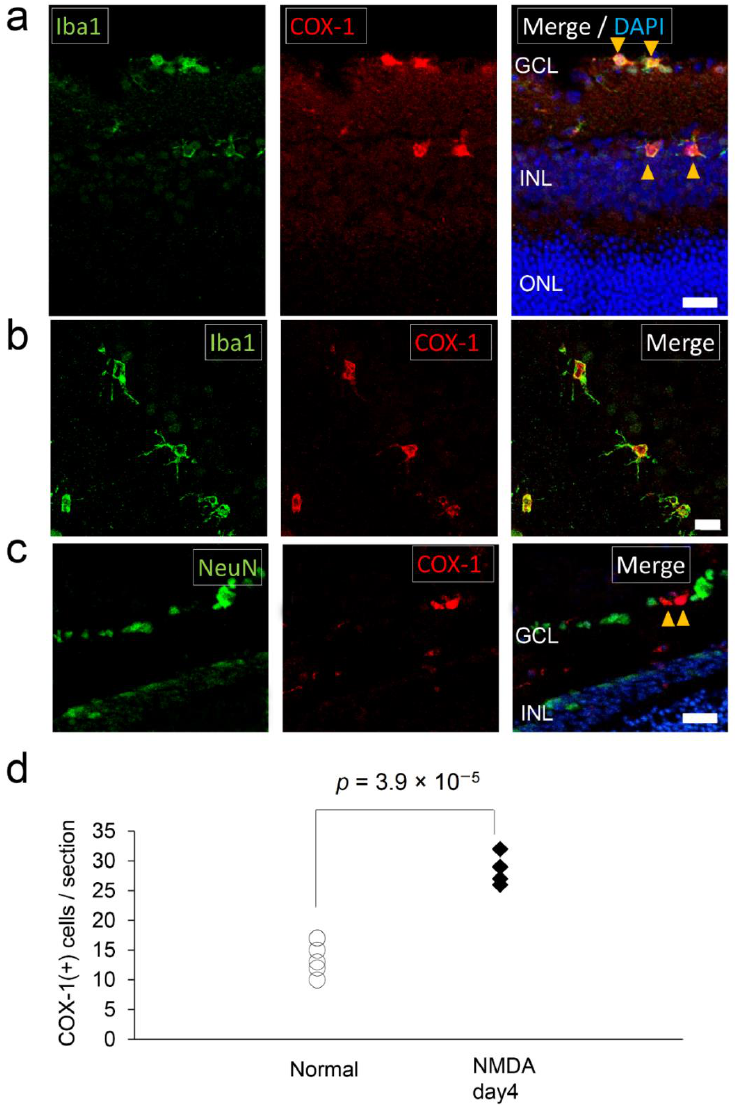
Figure 5. COX-1 + microglia/macrophage in the N -methyl-D-aspartate (NMDA) retinal neurotoxicity model. NMDA was administered into the vitreous cavity of the mice to induce neurotoxic damage to the inner layer of the retina. ( a ) Photomicrographs of the retina in NMDA-administrated model mice on day four after NMDA-administration labeled with Iba1 (left) and COX-1 (middle). Iba1 + microglia/macrophage localized in the GCL and the INL. COX-1 staining coincided with Iba1 + microglia/macrophage (yellow arrowheads). Scale bar, 20 µ m. ( b ) Photomicrographs showing a magnified image of microglia/macrophage in the retina of NMDA-administrated model mice. The processes of microglia/macrophage were shortened and the cell bodies of microglia/macrophage were larger than their resting state (also see Figure 1b). Scale bar, 10 µ m. ( c ) Photomicrographs of the retina in NMDA-administrated model mice labeled with NeuN (left) and COX-1 (middle). COX-1 staining (yellow arrowheads) did not coincide with NeuN + neurons in the GCL and the INL. Scale bar, 20 µ m. ( d ) A graph showing the number of COX-1 + cells in a retinal section of the NMDA- administrated retinal neurotoxicity model on day four after NMDA administration (NMDA day four) and normal mice ( n = 5). All COX-1 + cells were Iba1 positive. COX-1 + cells were significantly increased in the retina of the NMDA-administrated retinal neurotoxicity